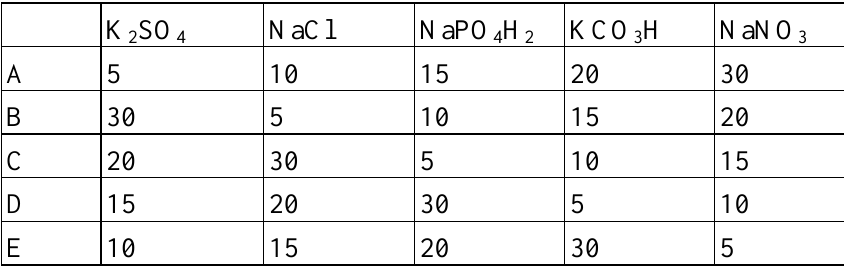
Table 2. The five artificial waters studied (labeled A to E) result from mixing different volumes (in mL) of 0.05 M salt